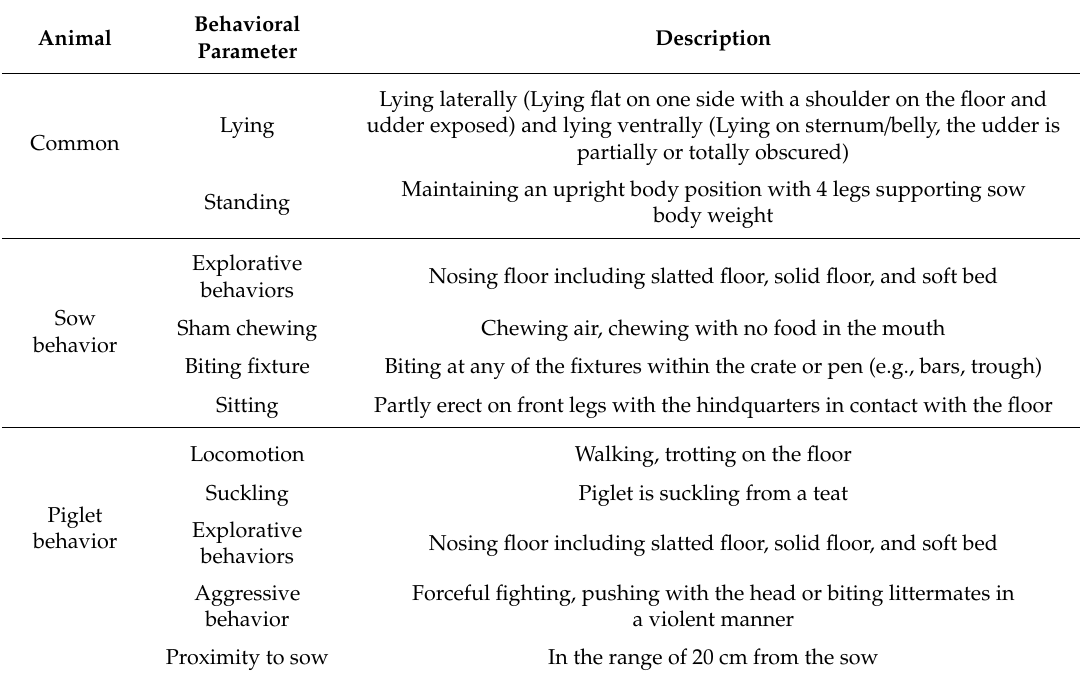
Table 1. Ethogram of behavior recorded during observations of sows and